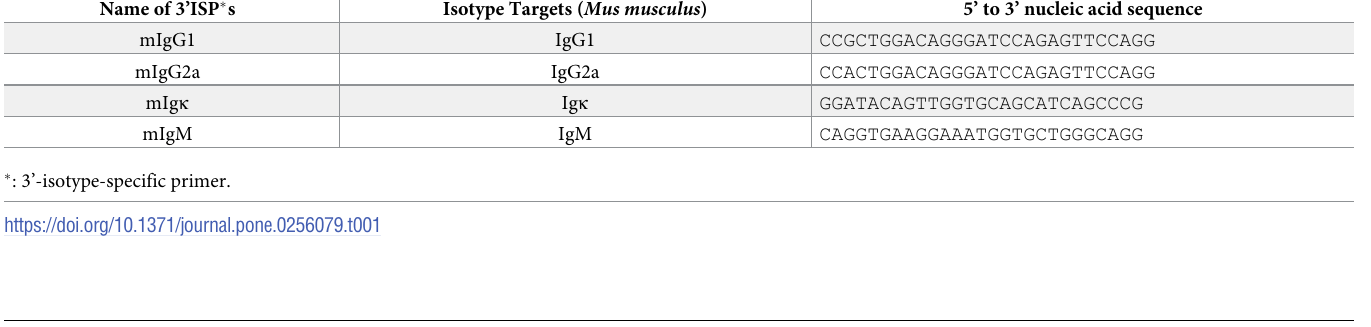
Table 1. List of the 3’ isotype-specific primer (ISP) sequences in this study. Name of 3’ISP � s Isotype Targets ( Mus musculus